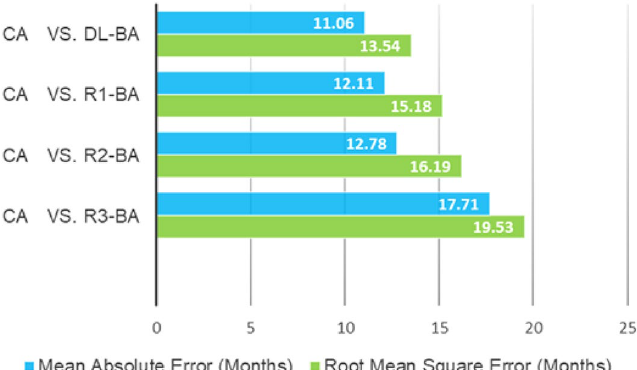
Figure 3. MAE and RMSE values between chronological age and each reviewer- and DL-estimated BA.